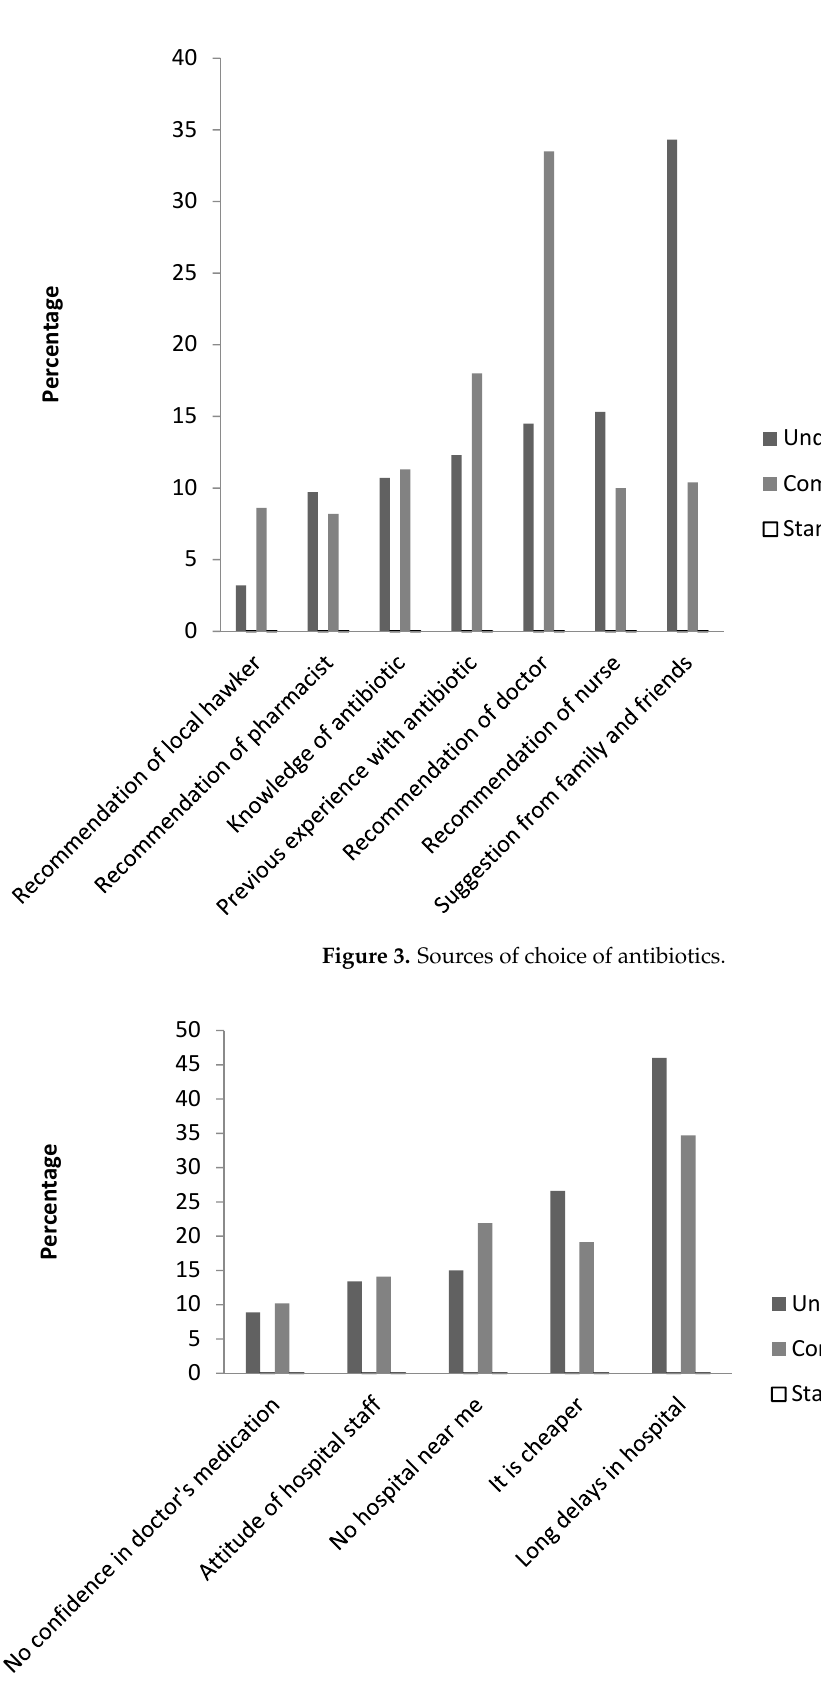
Figure 4. Reasons for self-medication with antibiotics.